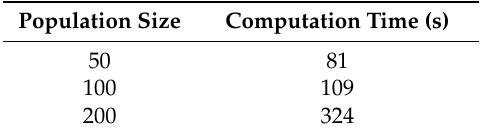
Figure 11. Convergence with different population sizes. Table 4. Computation time with different population sizes. Table 4. Computation time with different population sizes.